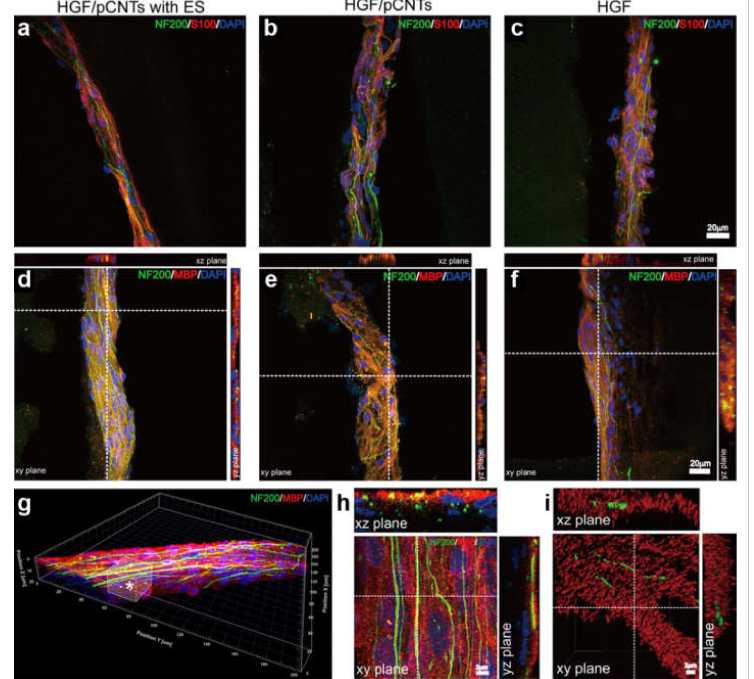
Figure 9. Neuronal axon myelination after 30-day cultivation within peptide-CNT hydrogels. ( a – c ) Immunostaining with anti-S100/anti-NF200 antibodies to probe the interactions between Schwann cells and axons and ( d – f ) with anti-MBP/anti-NF200 antibodies to probe myelination. ( g ) 3D structure of bundled axons within the hydrogel under electrical stimulation. The asterisk- marked region in ( g ) was investigated by analyzing ( h–i ) higher-magnification sections with axons and myelinated segments colored green and red, respectively. Adapted with permission from He, L. (2020) [153], copyright © 2021, American Chemical